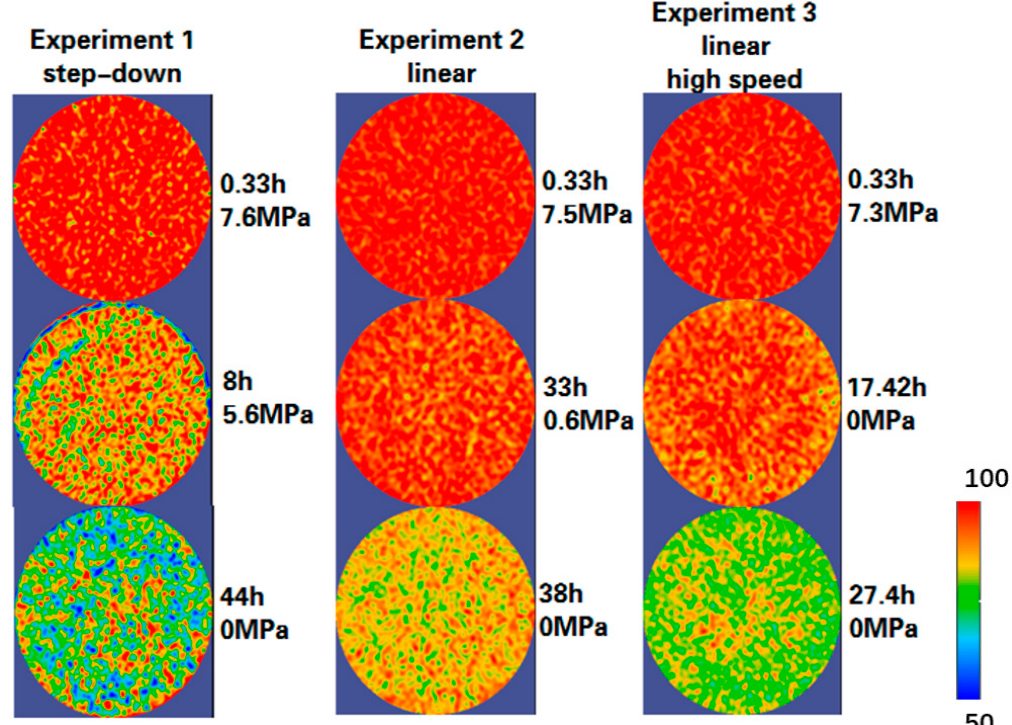
Figure 6. Oil saturation distribution of different slices in each experiment.